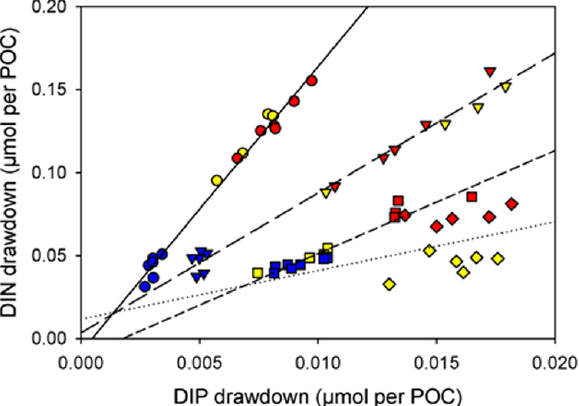
Fig. 3. Drawdown of DIN versus DIP (both normalized to per POC unit) during the PU (yellow), ETNA (blue) and WA (red) experiments. Linear regressions were fitted to the nu- trient drawdown in the treatments supplied with N : P ∼ 16 : 1 (circles; straight line: y = 17 . 18( ± 0.49) x − 0 . 01( ± 0.003), r 2 = 0 . 989, p < 0 . 0001 ) , N : P ∼ 8 : 1 (triangles; long-dashed line: y = 8 . 42( ± 0.30) x + 0 . 004( ± 0.004), r 2 = 0 . 984, p < 0 . 0001), N : P ∼ 5 : 1 (squares; short-dashed line: y = 6 . 21( ± 0.48) x − 0 . 01( ± 0.01), r 2 = 0 . 923, p < 0 . 0001) and N : P ∼ 2 : 1 (diamonds; dotted line: y = 2 . 93( ± 3.21) x + 0 . 01( ± 0.05), r 2 = 0 . 085, p = 0 .